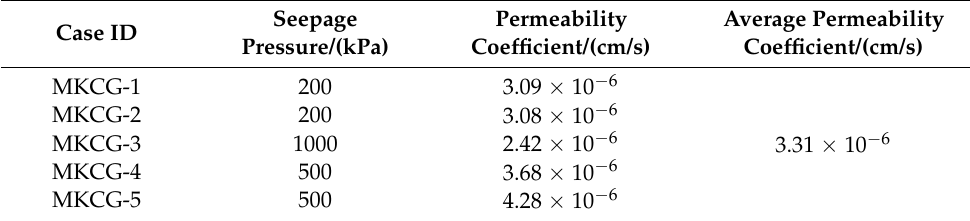
Table 8. Permeability coefficients of